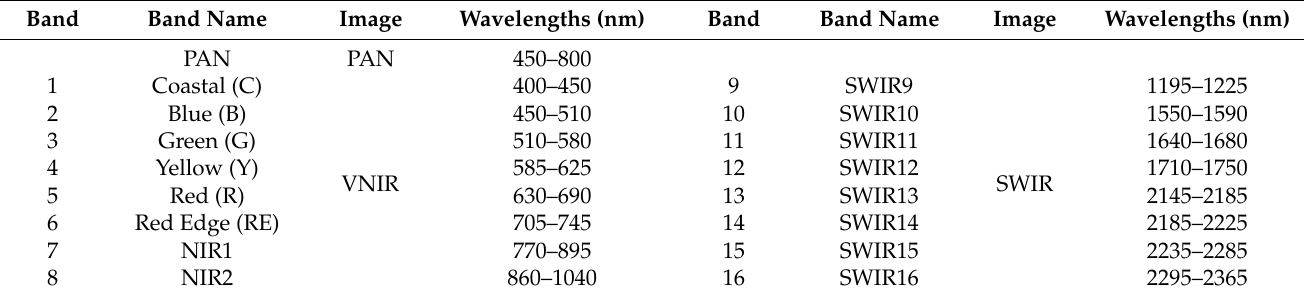
Table 1. WorldView-3 PAN, VNIR and SWIR bands and their wavelength ranges